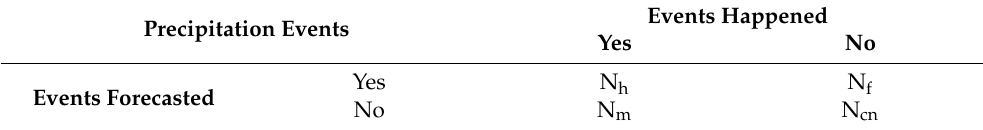
Events Happened Yes